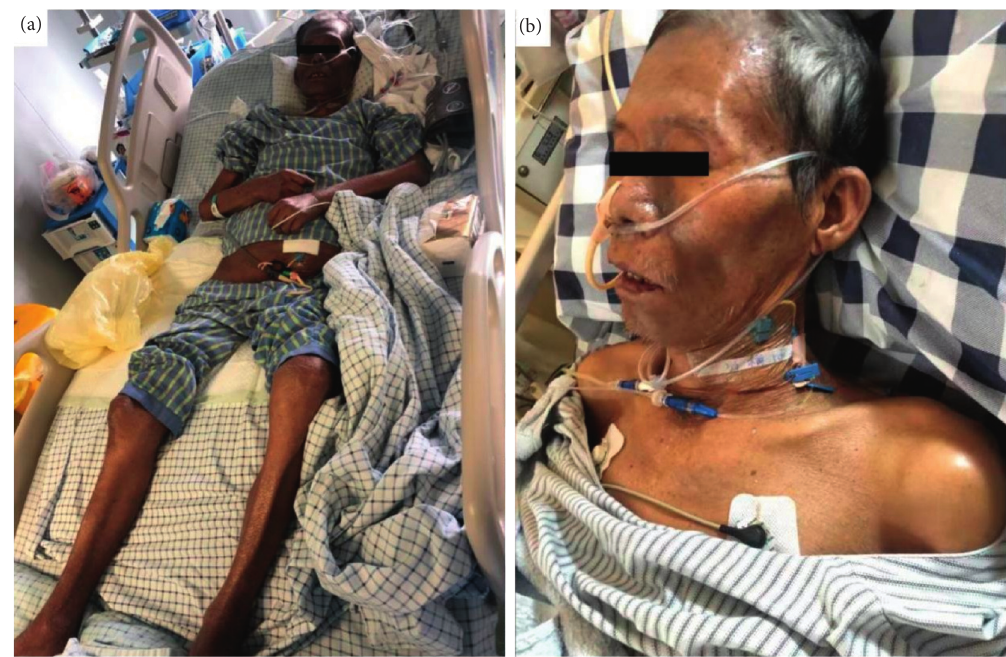
Figure 1: Photograph of the patient on (a) Day 17 of use polymyxin B and (b) Day 60 after the withdrawal of polymyxin B. A 68-year-old man received polymyxin B therapy for a Klebsiella pneumoniae blood infection. With treatment, the patient had progressive hyperpig- mentation (a) that significantly faded after the polymyxin B was withdrawn